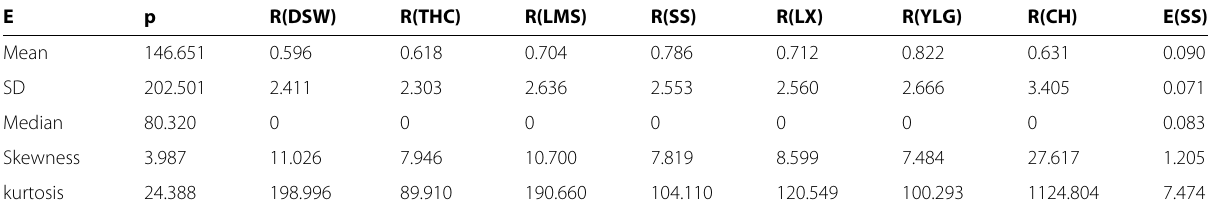
Table 1 Descriptive statistics of daily flow and relevant data from 1998 to 2010 in Changhua dataset, where DSW, THC and other abbreviates represent names of rainfall, evaporation and gaging stations, and p , R and E refer to flow rates observed at CH, rainfall observed at rainfall stations and evaporation observed at SS, respectively